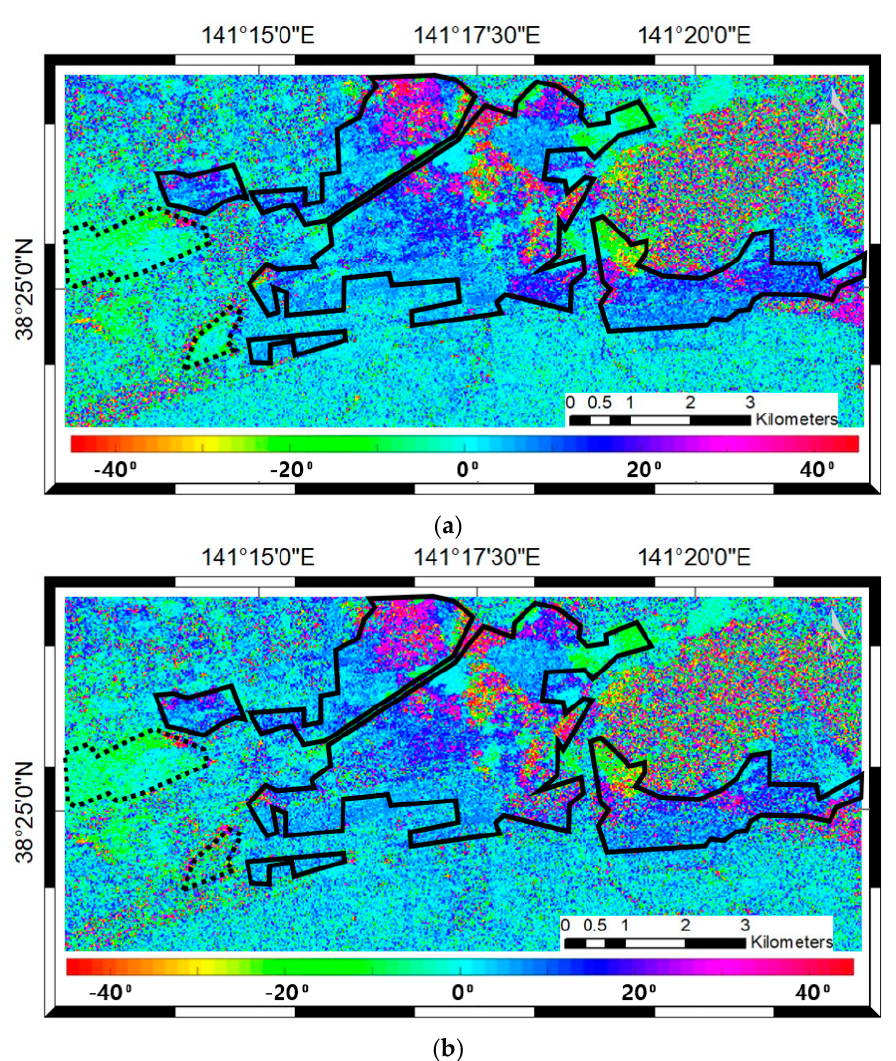
Figure 7. Estimated POAs using PolSAR data: ( a ) POAs from ALOS/PALSAR-1 on 2 April 2009; and ( b ) POAs from ALOS/PALSAR-1 on April 8, 2011. The range of the PolSAR POAs is from − 45° to 45°. The densely built-up areas are highlighted with black solid lines. The areas highlighted with black dotted lines are the sparsely built-up areas.